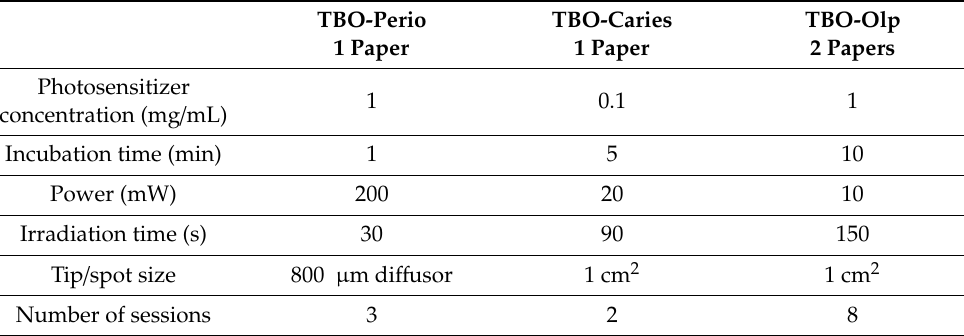
Table 10. Studies with toluidine blue (TBO).